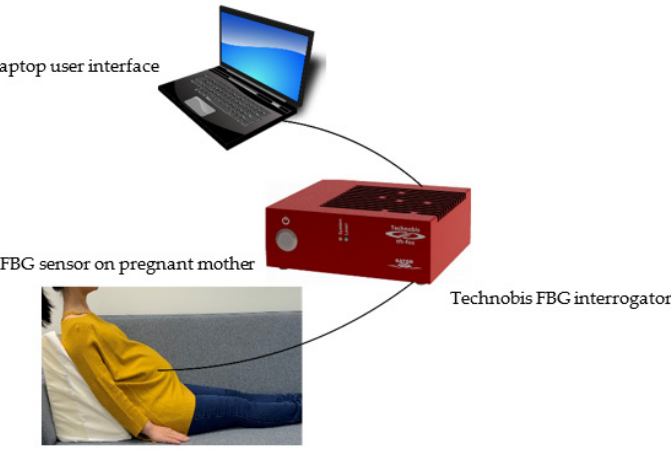
Figure 4. Volunteer experimental setup.